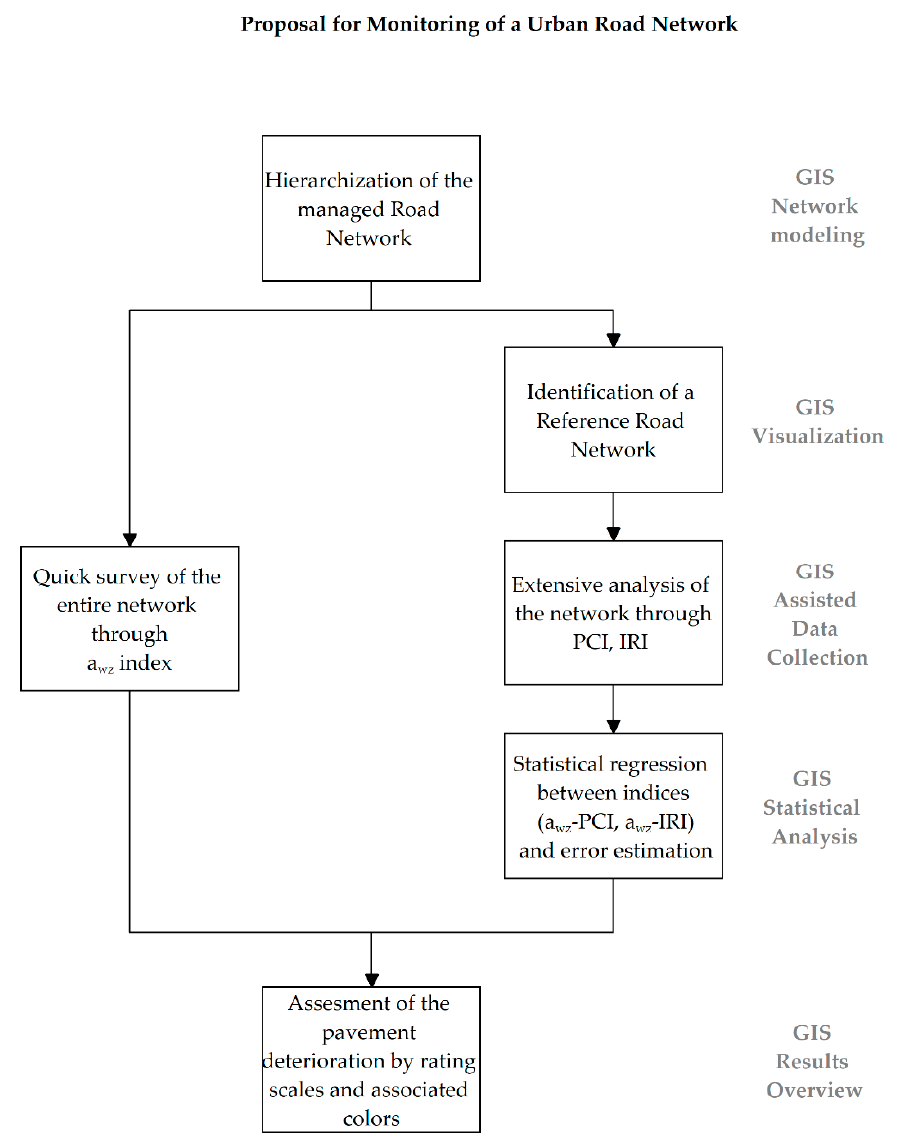
Figure 1. Flowchart of the proposed methodology.